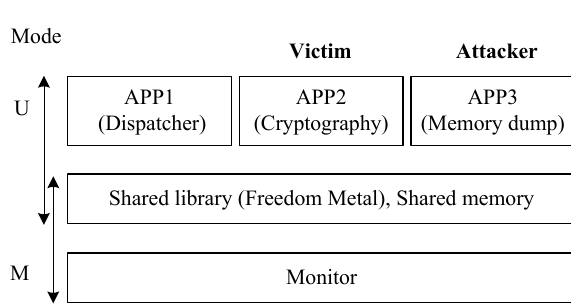
Figure 5: System structure of PoC TEE. Three applications are controlled by the monitor, and they share data with shared memory.